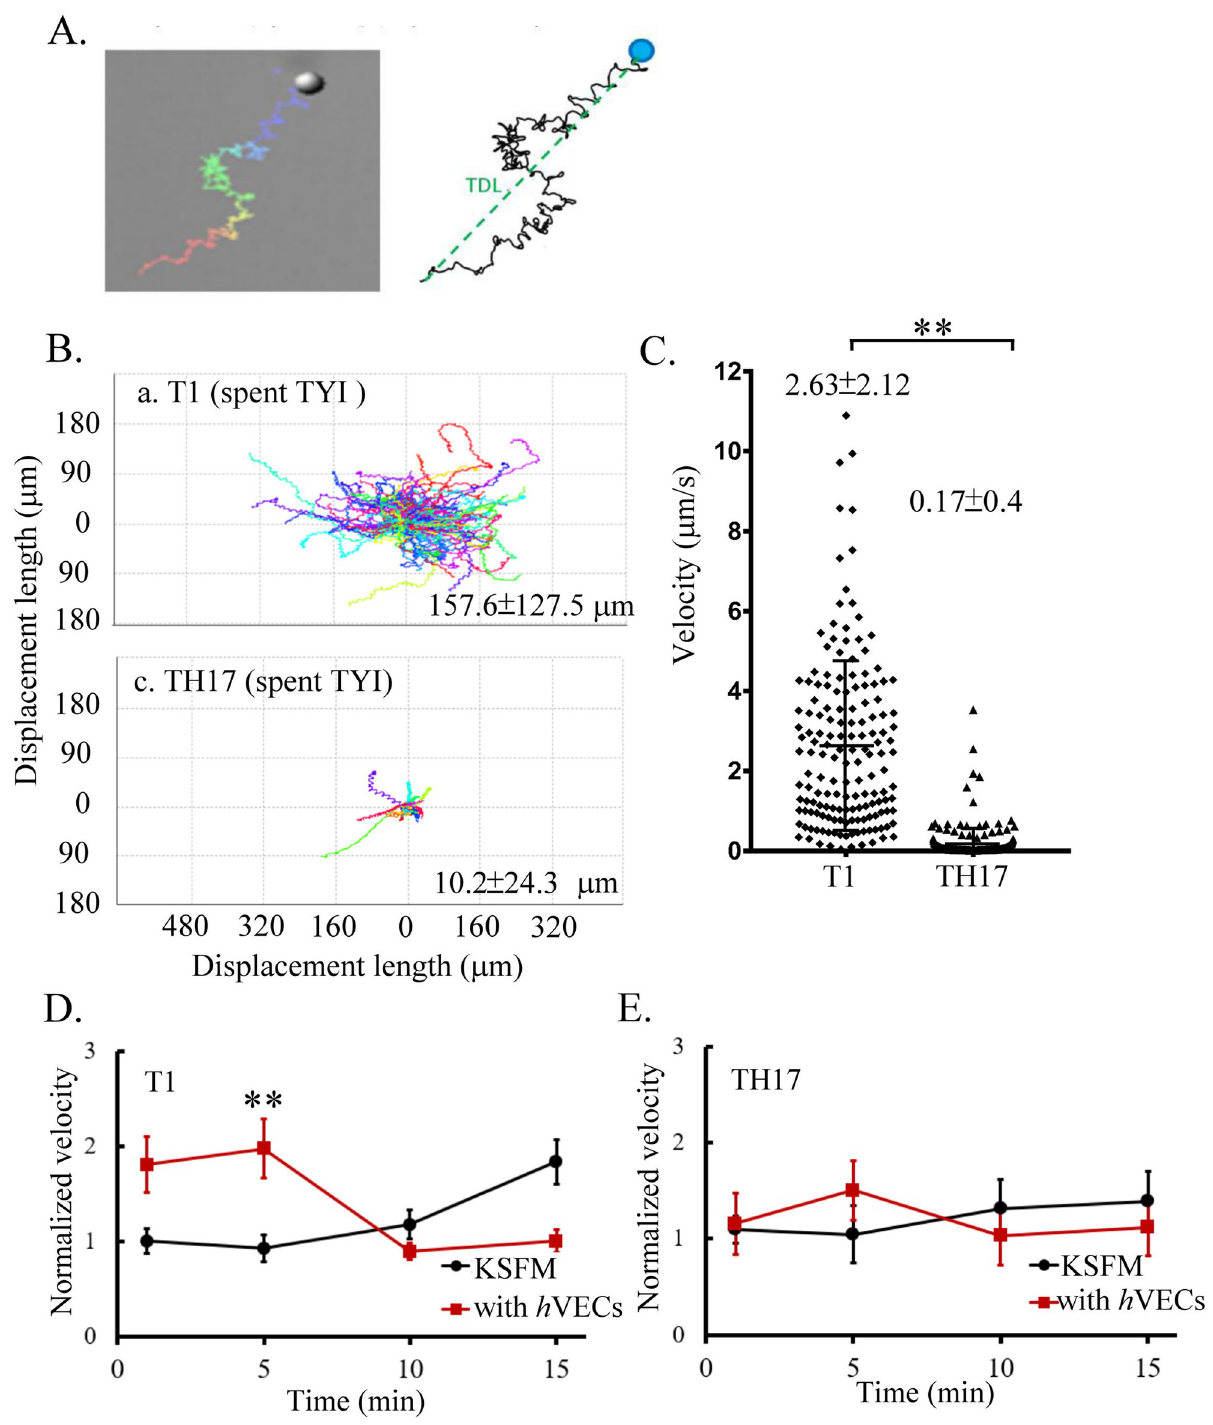
Fig 7. Motility of nonadherent versus adherent T . vaginalis isolates. The tract of a single TH17 or T1 trophozoite migrating on a glass slide for 1 min is depicted in A. The migratory paths from ~50 trophozoites are shown in B, with the average track displacement length (TDL). The average velocities with standard deviations were statistically analyzed by Student’s t-tests as shown in C. The relative velocity of T1 in D. or TH17 in E., the trophozoites cultured in KSFM or with h VECs over 15 min was normalized by the average velocity of those in 1 min post-incubation in KSFM. The assays were repeated three times. For D. and E., the statistical analysis was measured by Bonferroni post hoc tests (n = 10 to 30 for each group). The error bars represent standard deviations, P < 0.01( �� ) and P < 0.05( � ).